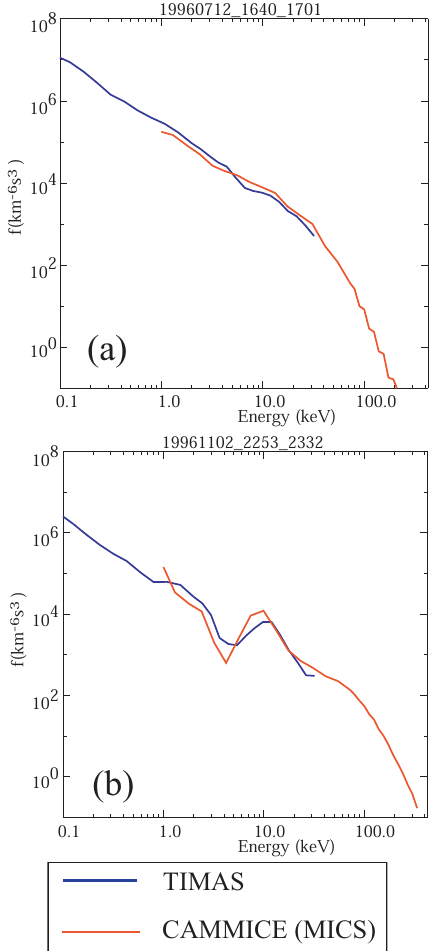
Fig. 7. Example IDFs from the statistical database used in Badde- ley et al. (2004). TIMAS data are shown in blue and CAMMICE (MICS) data are shown in red. Panel ( a ) illustrates an IDF without a positive gradient region and thus would not be considered as a candidate for a wave energy source. Panel ( b ) indicates an IDF that would be a suitable wave energy